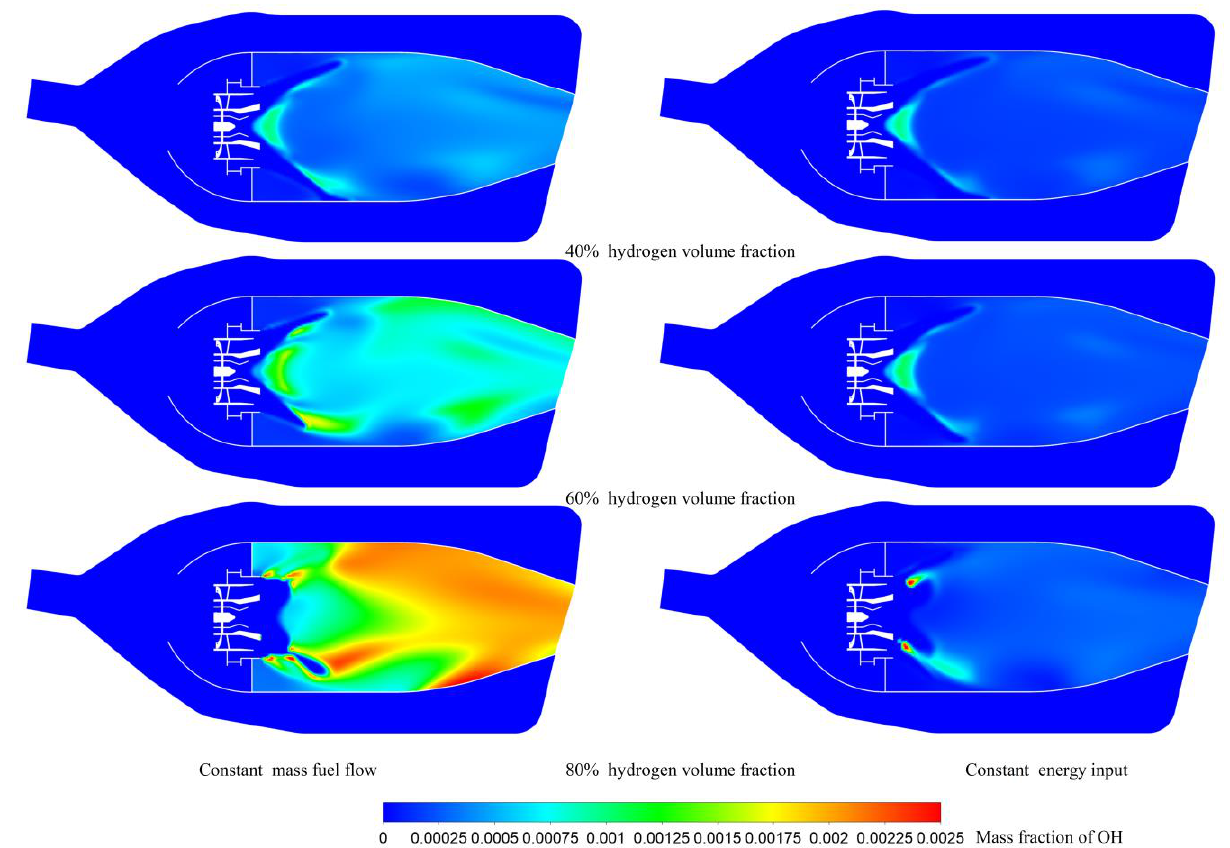
Figure 11. Contours for the mass fraction of OH on the central plane of the combustor under different fuel conditions.